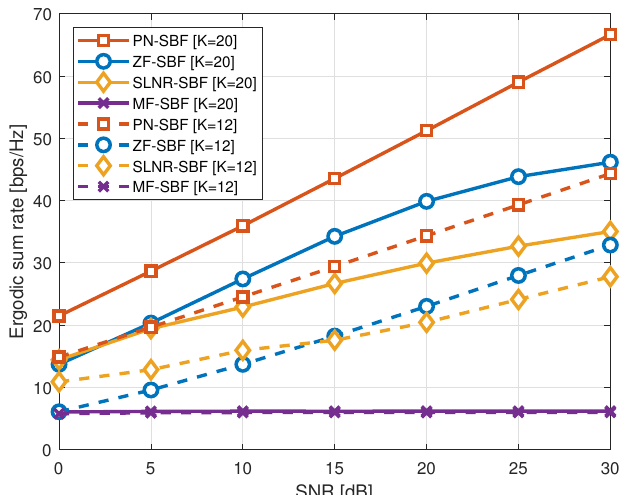
Figure 2. Ergodic sum rate of the SBF schemes, where M = 128, K H = K /4, K L = 3 K /4, ∆ H = 10 ◦ , and ∆ L = 60 ◦